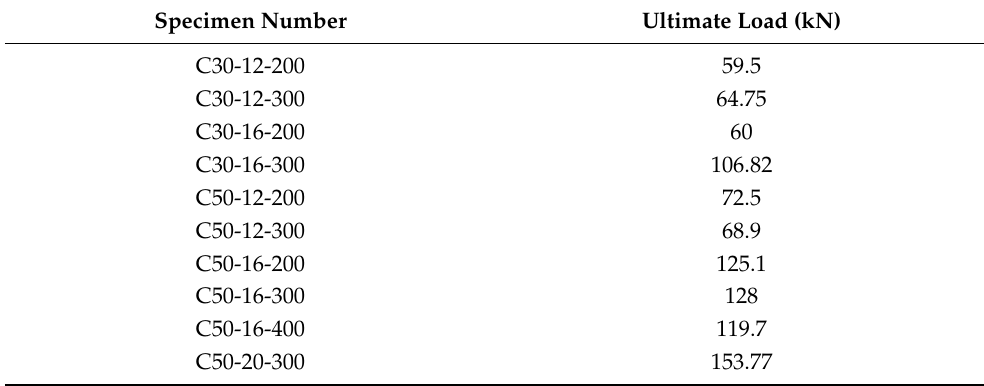
Table 2. Ultimate loads in kN for pull-out reinforced concrete specimens of concrete strength grades of 30 and 50 (C30–C50), rebar diameter of 12, 16, and 20 mm, and anchorage lengths of 200, 300, and 400 mm [1].